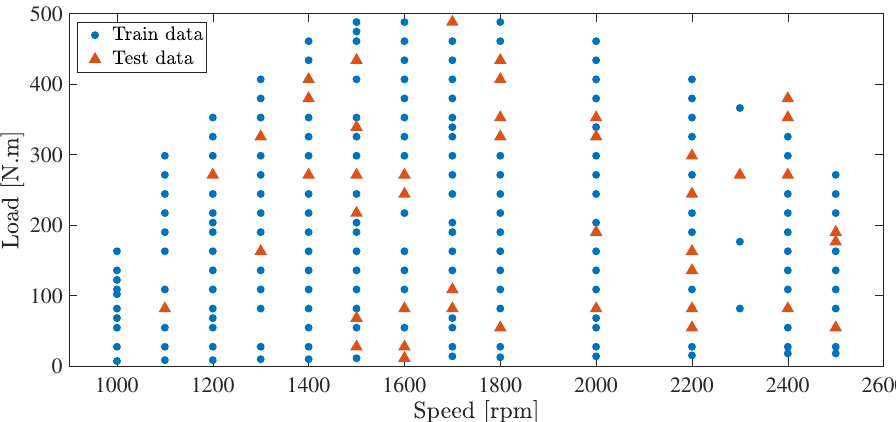
Figure 8. Training and test data for ML approaches, 175 data points are used as the training dataset (80%) and 44 data points are used as the testing dataset